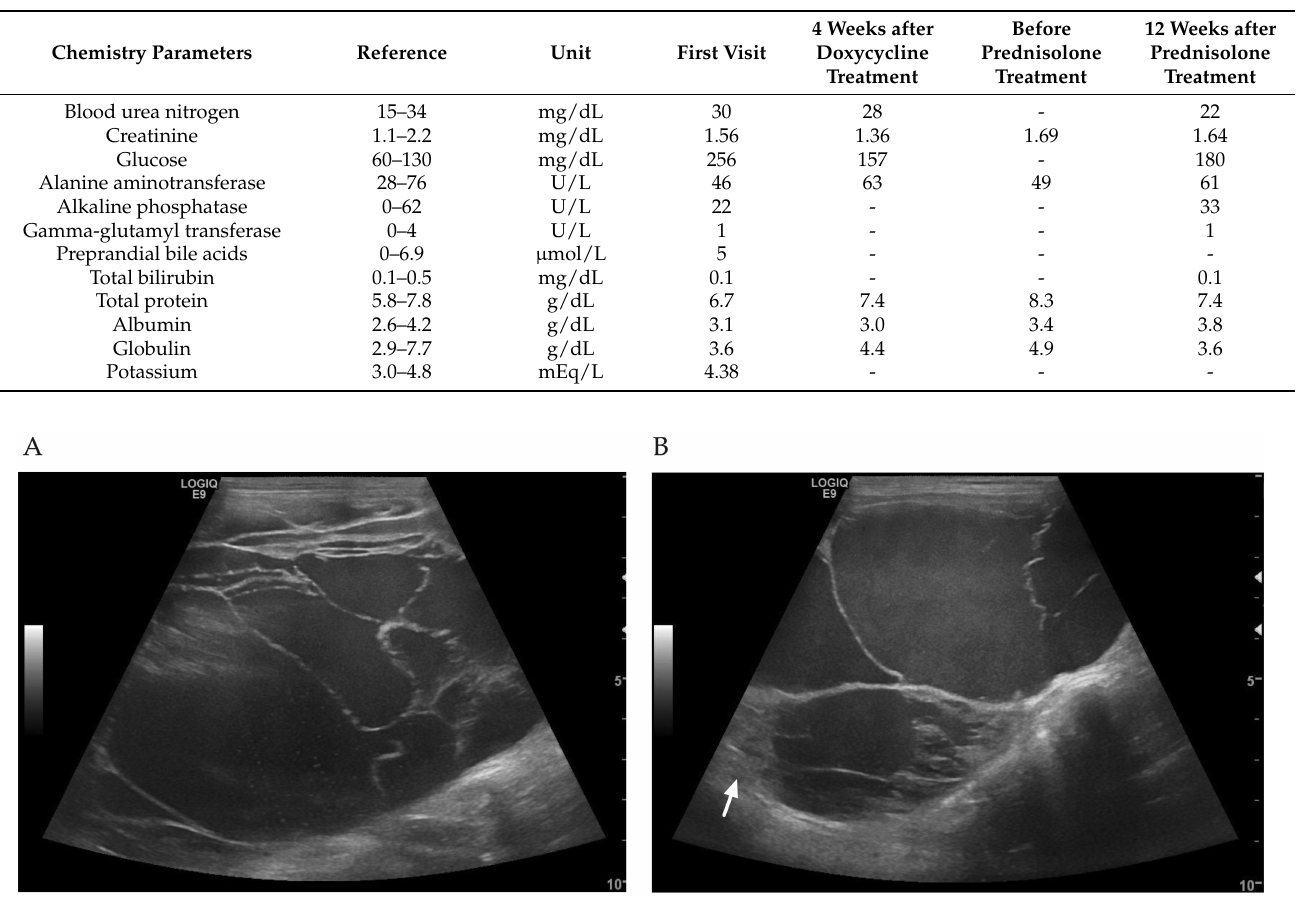
Figure 1. Ultrasonographic findings on the first visit. ( A ) Large hepatic cysts contained hypoechoic fluid and internal septations. ( B ) Hepatic cysts surrounded with irregular walls. There was a small area of mild heterogeneous liver parenchyma